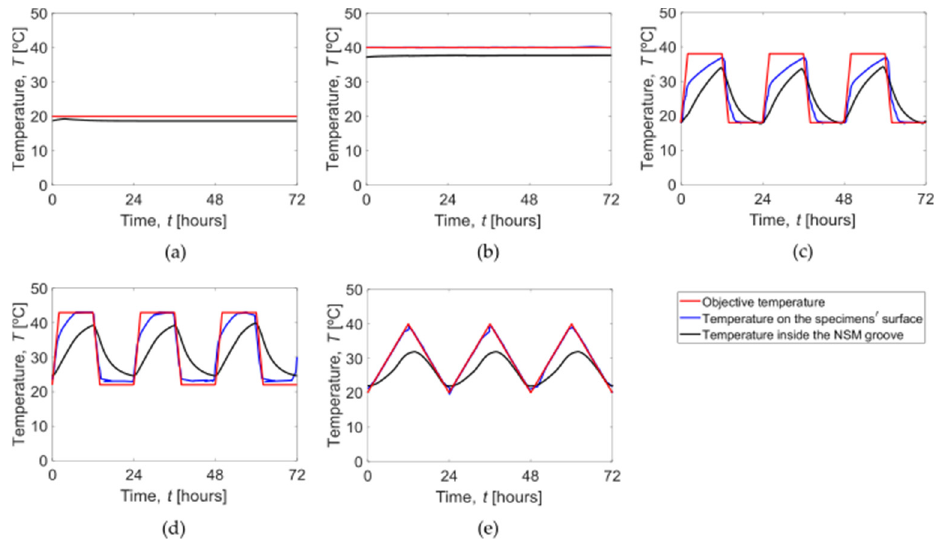
Figure 3. Temperature in the experimental series: ( a ) S1; ( b ) S2; ( c ) S3 ‐ A; ( d ) S3 ‐ B; ( e ) S4.